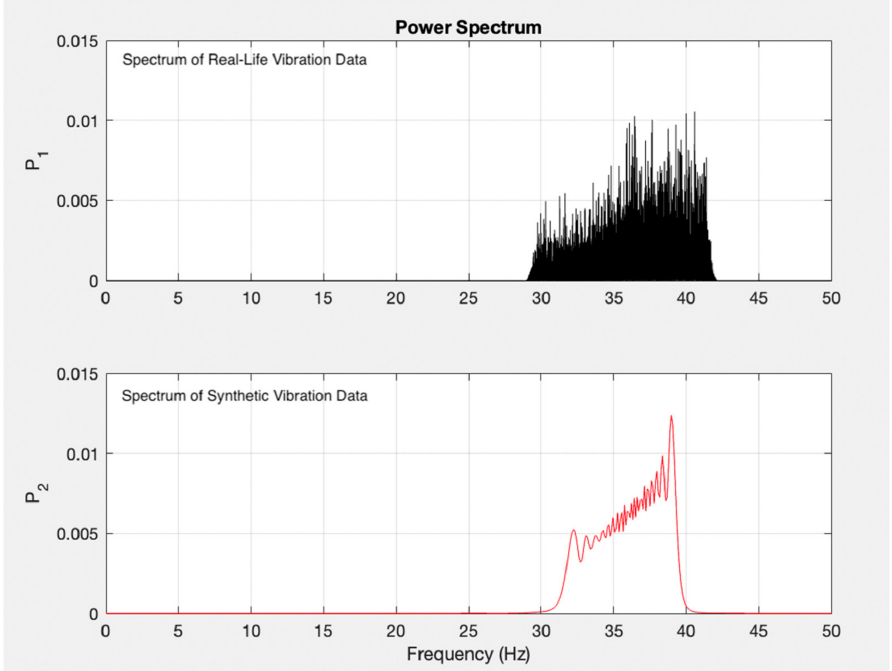
Figure 6. Result of the power spectra